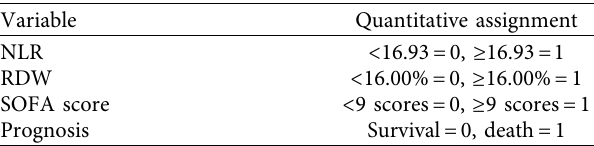
Table 2: Quantitative assignment table.